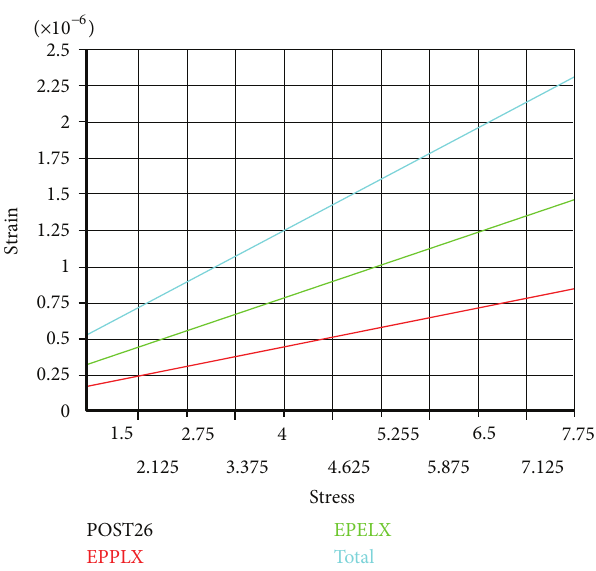
Figure 7: Curves among total, elastic, and viscous strain when the ICP increment is 2.5 kPa. Here EPELX is elastic strain curve, and EPPLX is viscous strain curve. The viscous strain is about 40% of total strain.